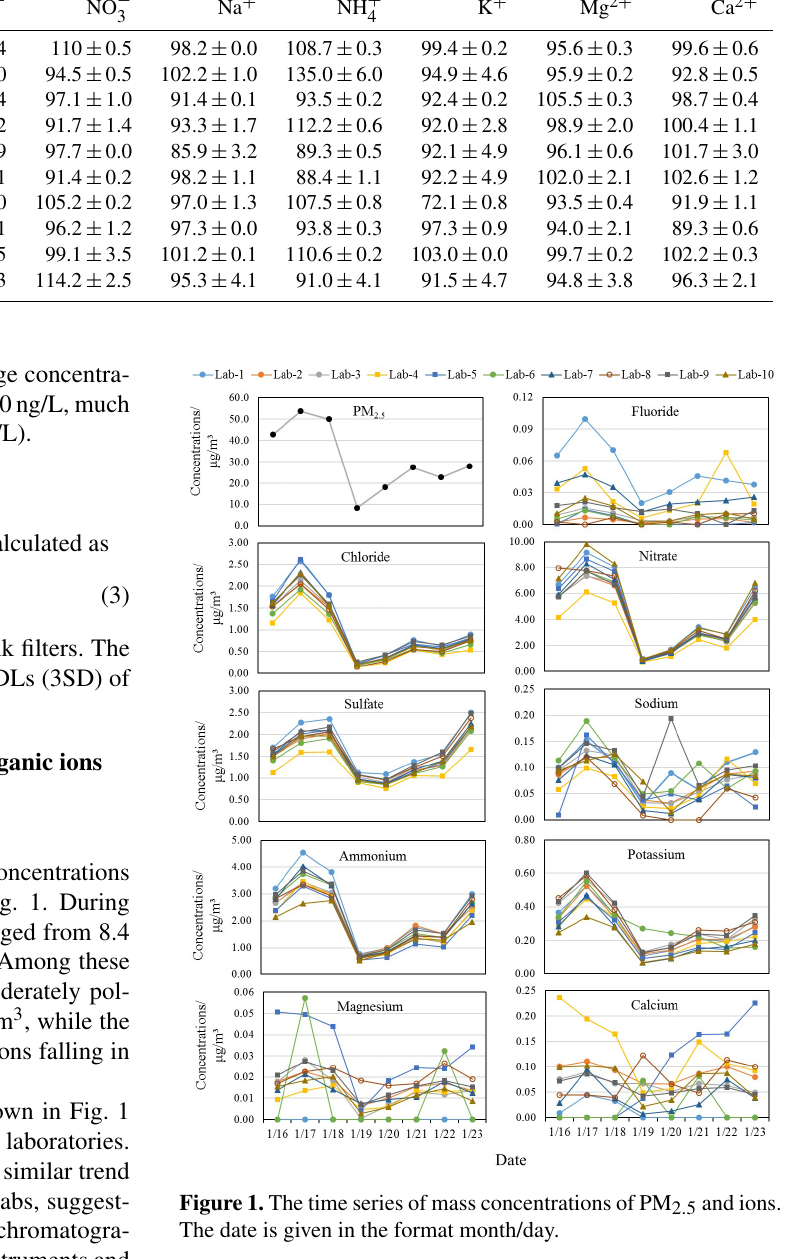
Table 2. Detection accuracy (%) of water-soluble inorganic ions in certified reference materials measured by the 10 laboratories. Lab no.